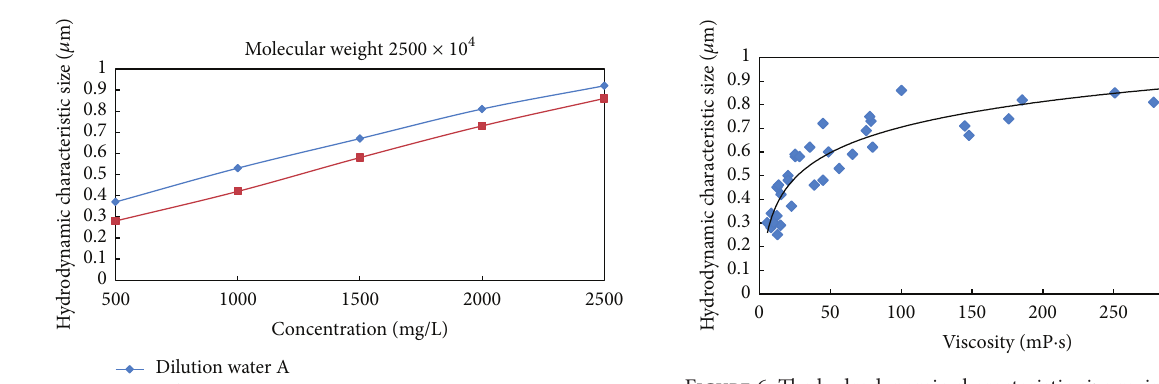
Figure 6: The hydrodynamic characteristic size maintained a good nonlinear relation with viscosity of polymer